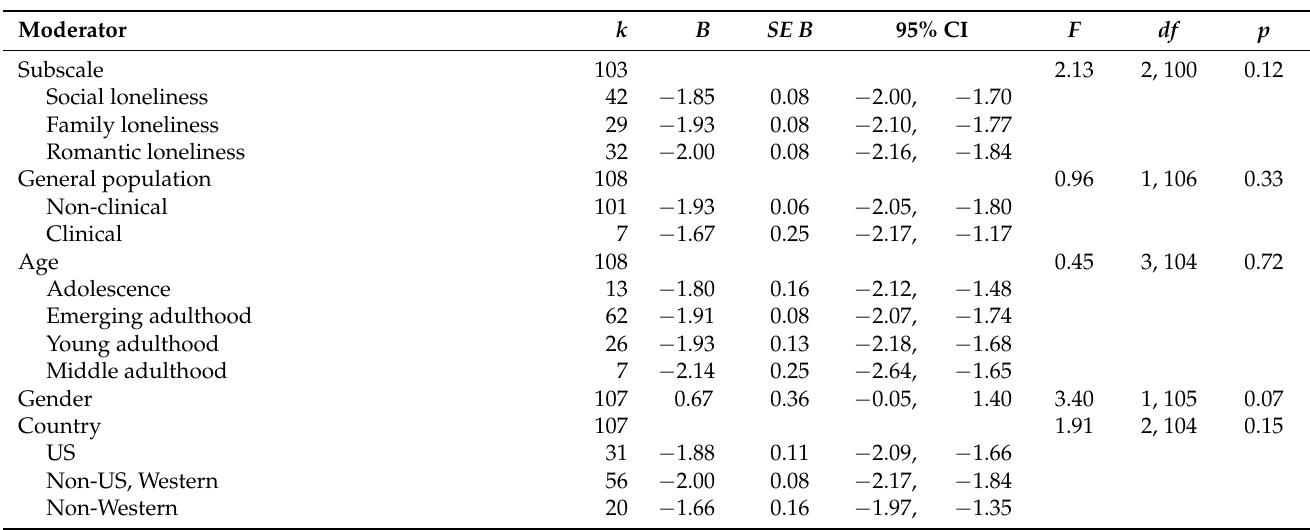
Table A3. Separate Regression Analyses for the Moderators Predicting Reliability Scores of the Social and Emotional Loneliness Scale for Adults